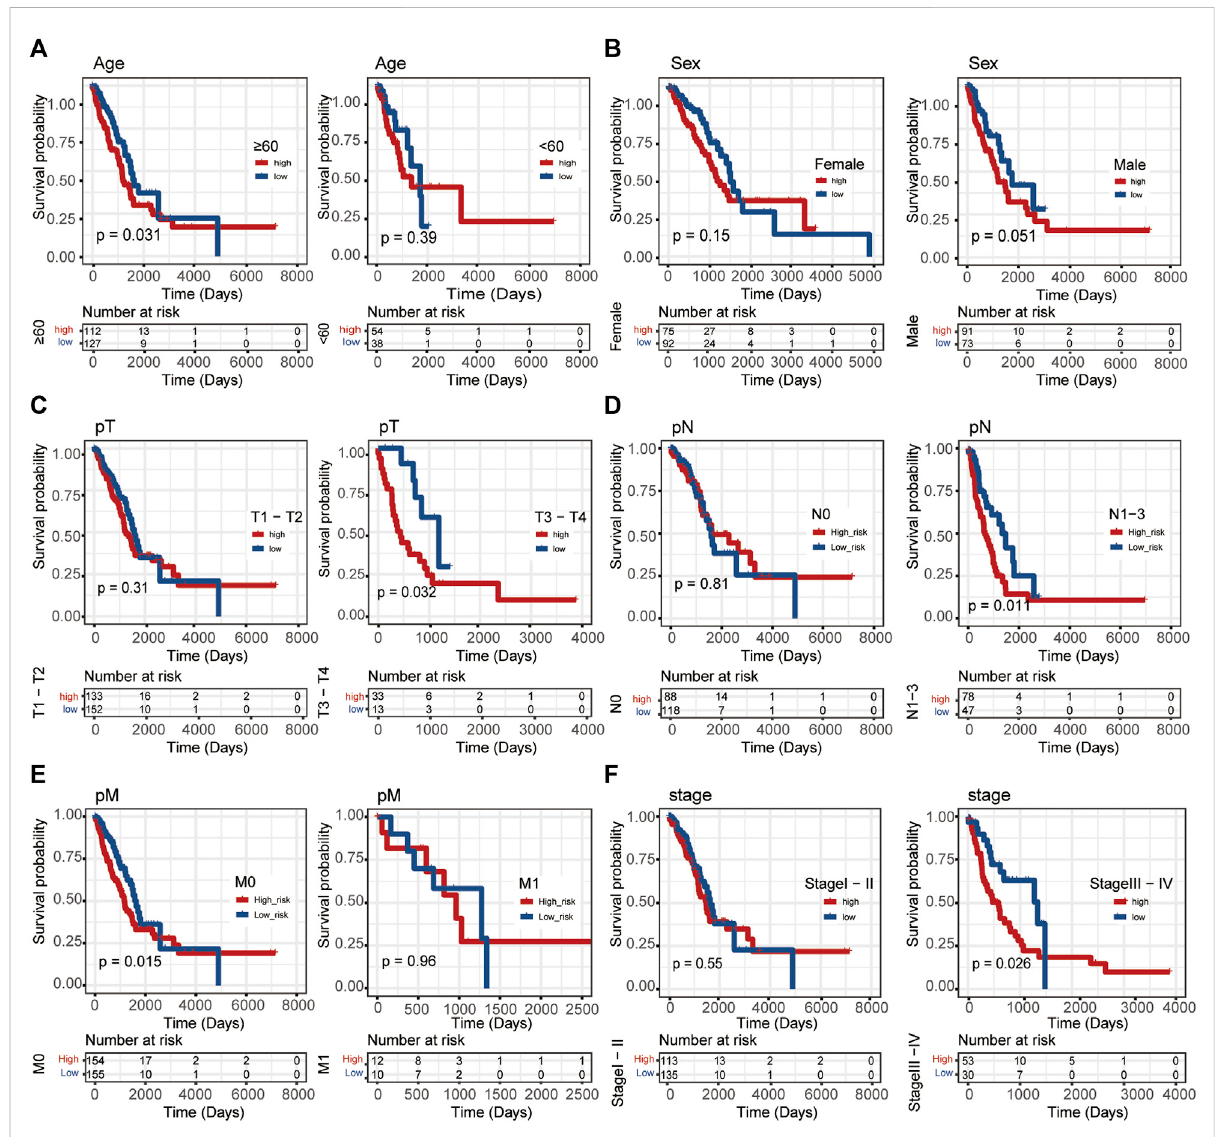
FIGURE 3 Strati fi edsurvivalanalysisinTCGA-LUAD. (A) Age. (B) Sex. (C) Tstage. (D) Nstage. (E) Mstage. (F) Pathologicalstage.Theordinaterepresentsthe survival rate, the abscissa represents the OS, and the red curve represents the group of samples with high expression of the gene, bounded by the median expression level. The blue curve represents the group of samples with low gene expression, with signi fi cant differences among different groups, p <